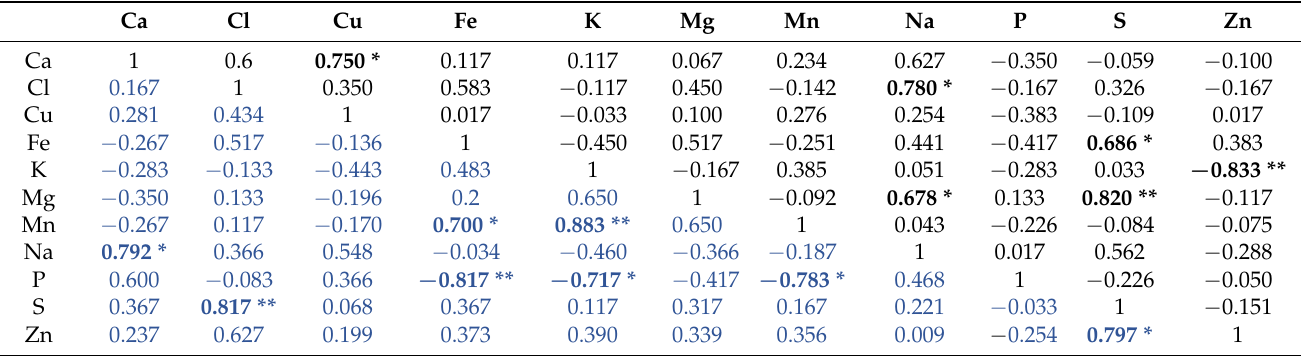
Table 4. Spearman’s correlation of essential macronutrient elements of sand (in blue) and silt (in black)